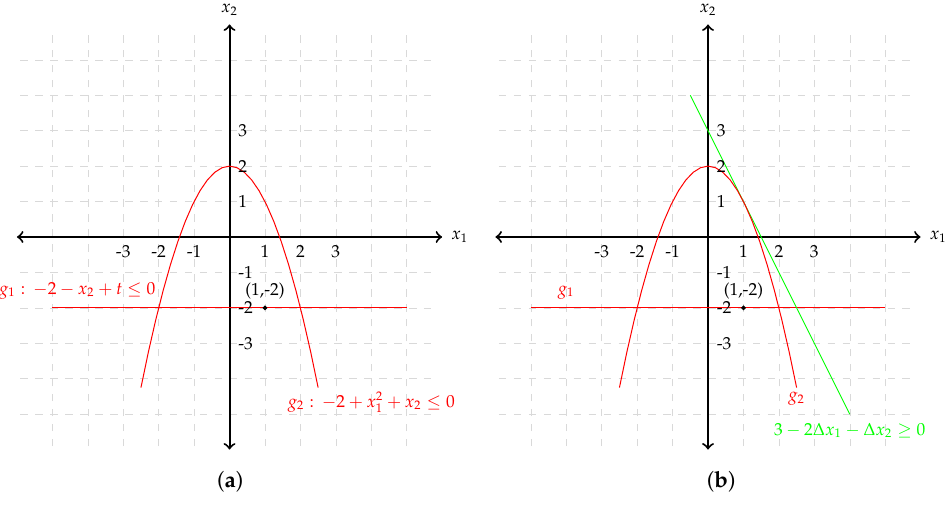
2 ) and t = 0. − 2 to x 2 = 1 − −